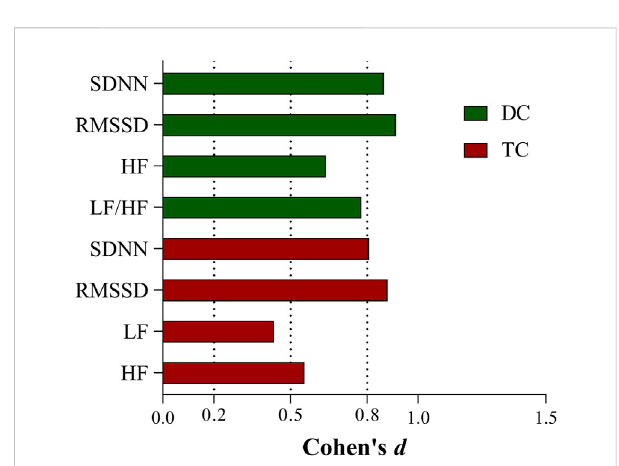
FIGURE 2 Effect sizes of HRV indicators with differences before and after chemotherapy in the DC and TC